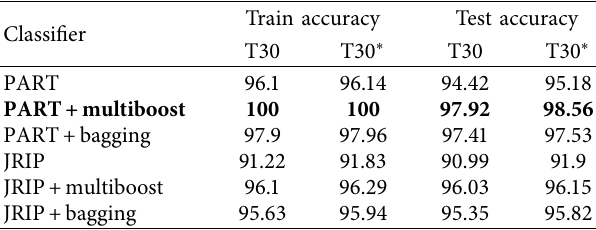
Table 12: Classifier performance in terms of train accuracy and test accuracy values for Exp.